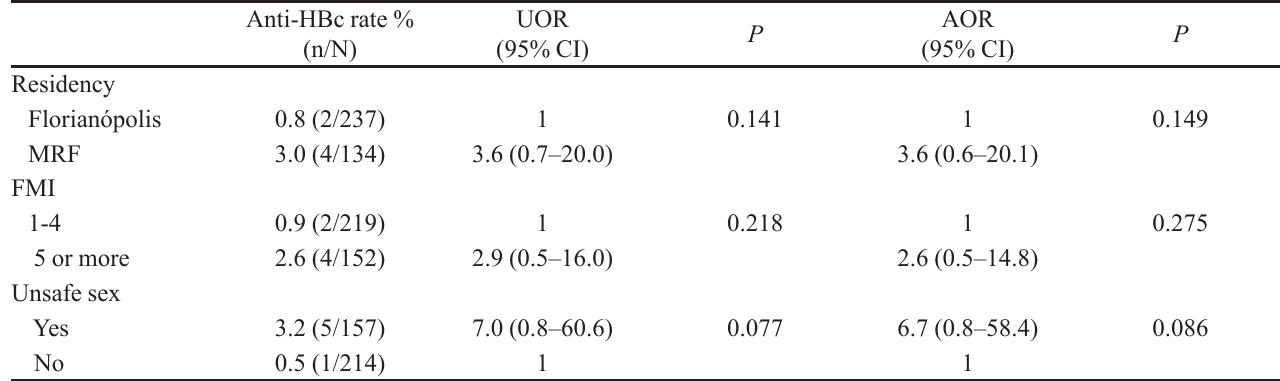
TABLE III - Multivariate non-conditional logistic regression analysis between variables significant at P < 0.2 in bivariate